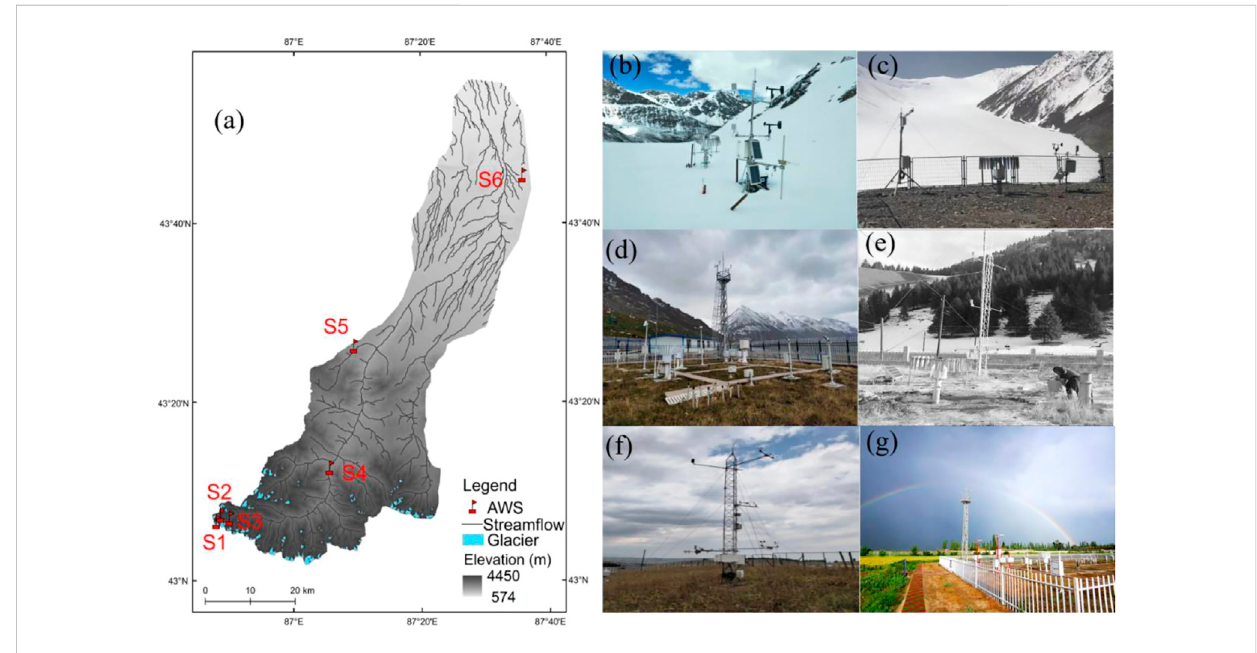
FIGURE 1 Maps showing (A) locations of meteorological stations in the Urumqi River Basin and (B – G) photographs of the observation site for S1 – S6.